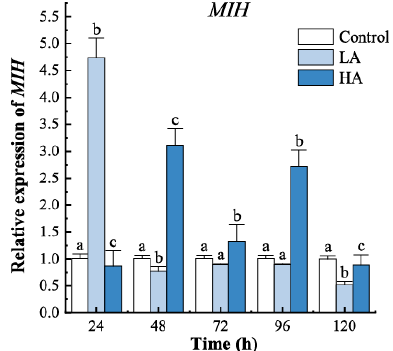
Figure 3. MIH mRNA expression in juvenile crabs exposed to ammonia nitrogen stress. At the same time, the letters indicate significant differences between experimental groups ( p < 0.05).